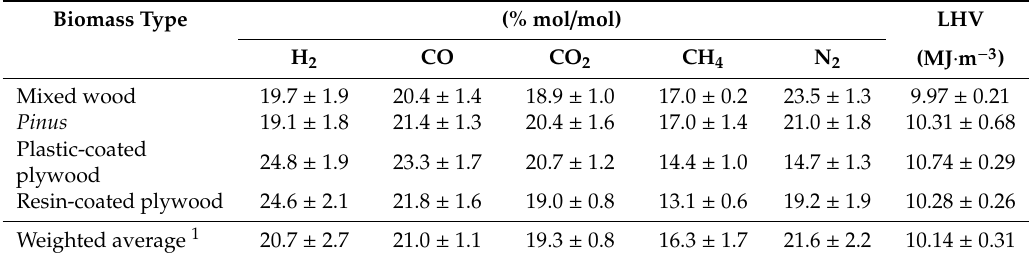
Table 8. Gaseous fuel composition for the 900 ◦ C gasification.